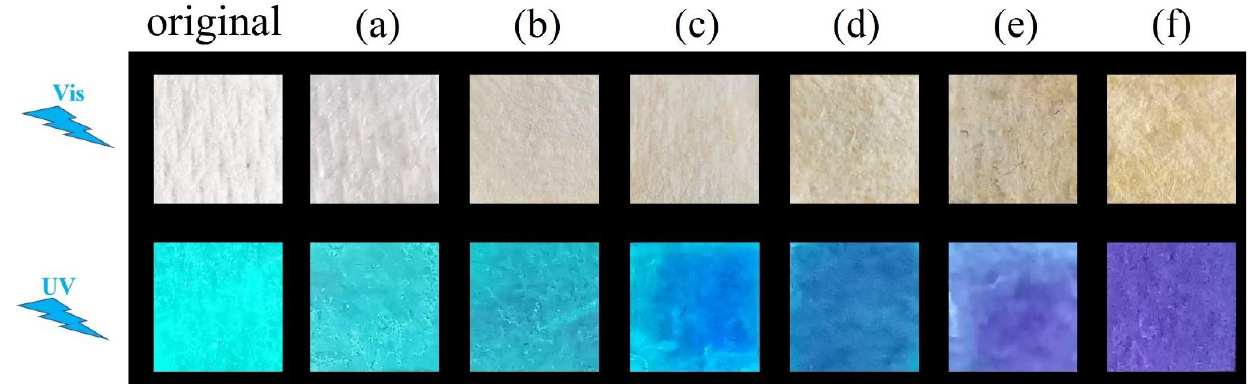
Figure 4. SEM images in different sizes of paper-based sensor TPE4A : 200 µm ( a , b ), 100 µm ( c ), and 50 µm ( d ).